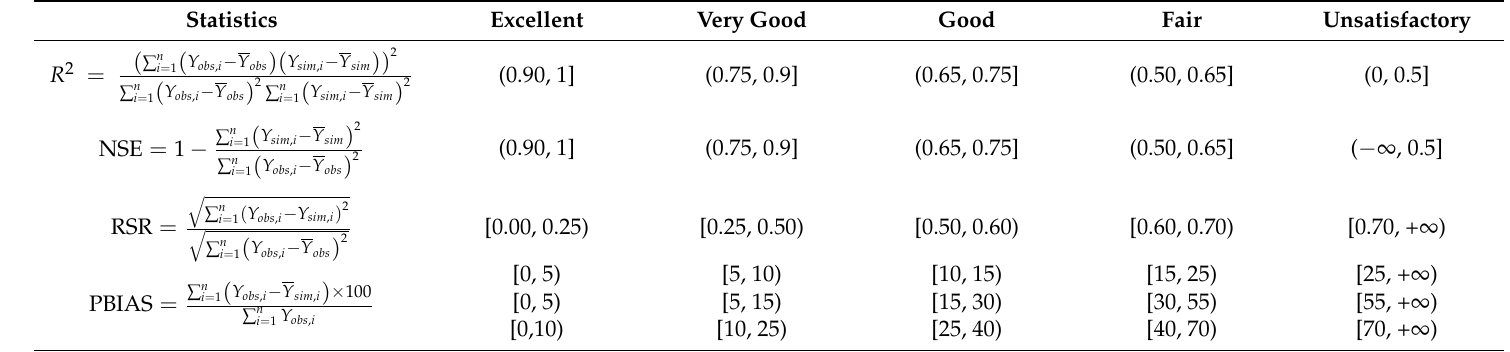
Table 5. Statistics used to evaluate